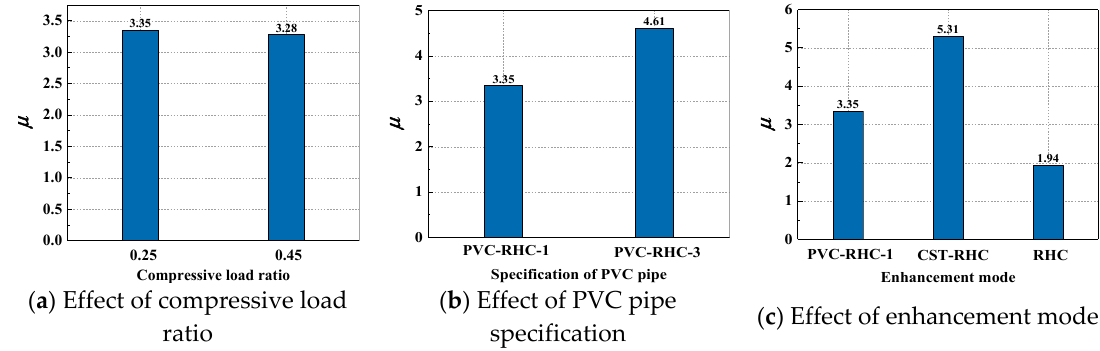
Figure 9. Parametric analysis of ductility.